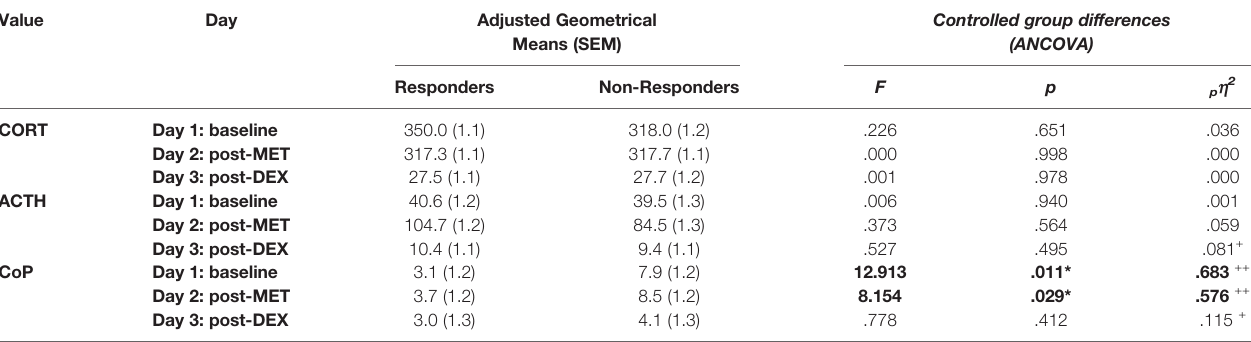
Values are presented as geometric mean values (SEM) adjusted for age, gender, history of previous depression, BMI and smoking. Group differences were assessed through a linear